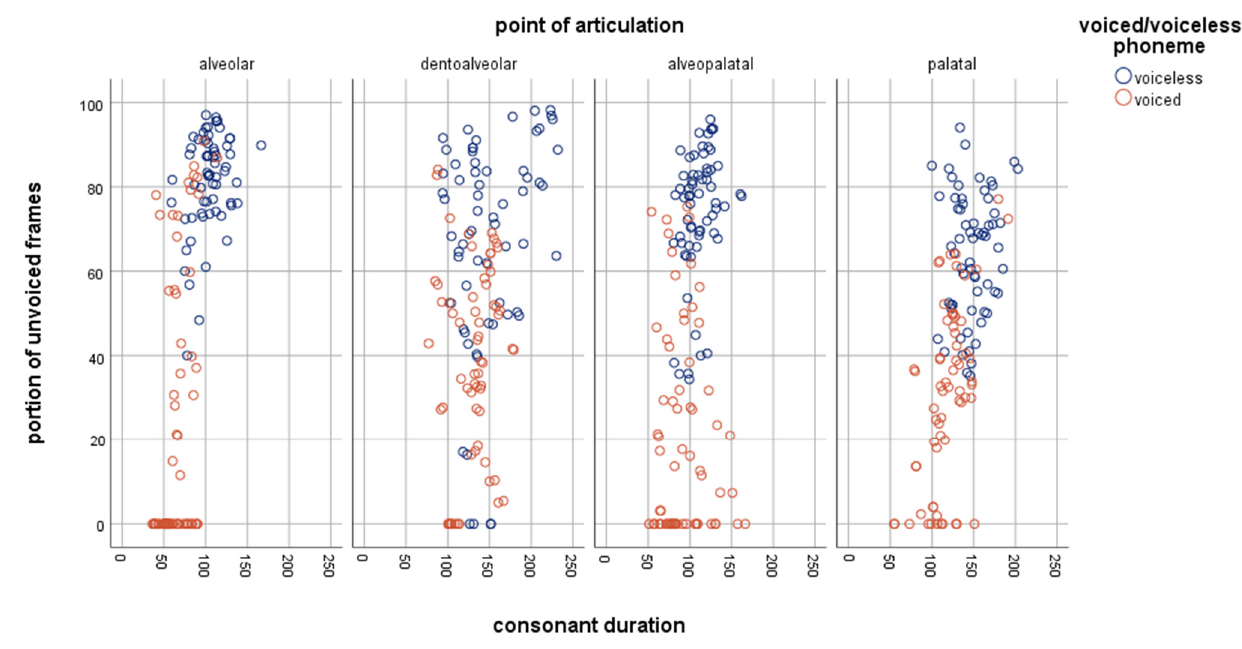
Figure 1. Scatter plots showing the relationship between proportion of unvoiced frames and dura- tion and the voicing value in the four sibilant